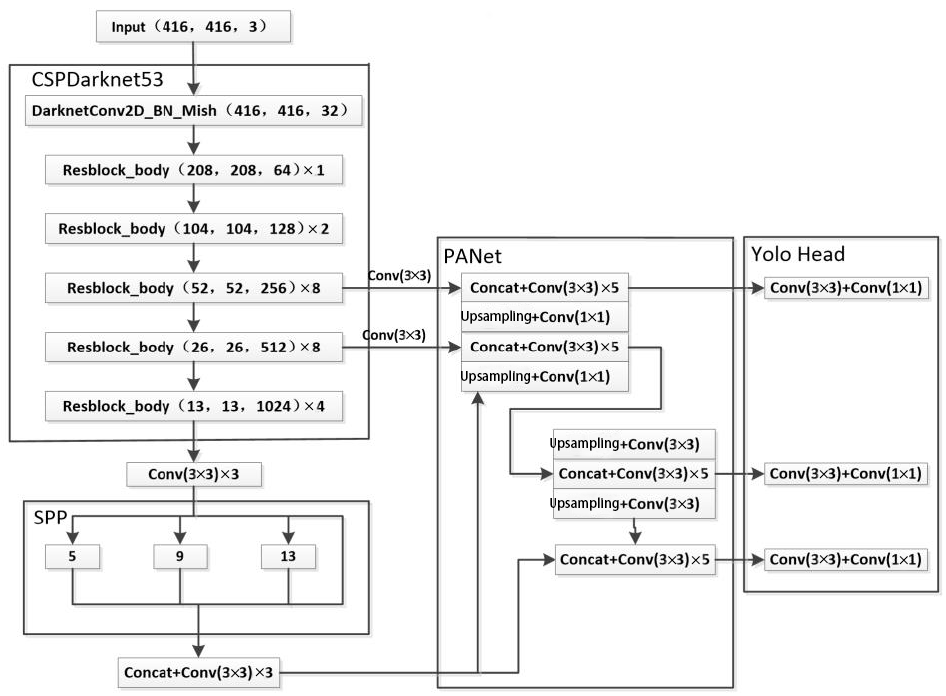
Figure 8. Network model structure figure of YOLOv4.